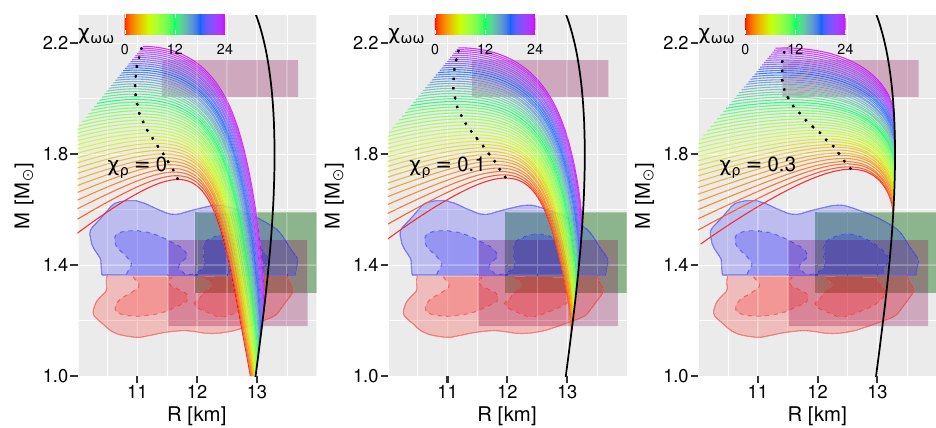
Figure 1. M ( R ) diagrams as a function of χ ωω (color scale) for three values of χ ρ : 0 (left), 0.1 (center), and 0.3 (right). The solid black line represents the purely hadronic M ( R ) sequence, and the black dotted specifies the maximum mass of each hybrid EoS. The rectangular regions enclosed by dotted lines indicate the constraints from the millisecond pulsar PSR J0030 + 0451 NICER x-ray data [10, 11], while the top brown region is from [12]. The top blue and bottom red regions indicate, respectively, the 90% (solid) and 50% (dashed) credible intervals of the LIGO / Virgo analysis for the GW170817 event [5].